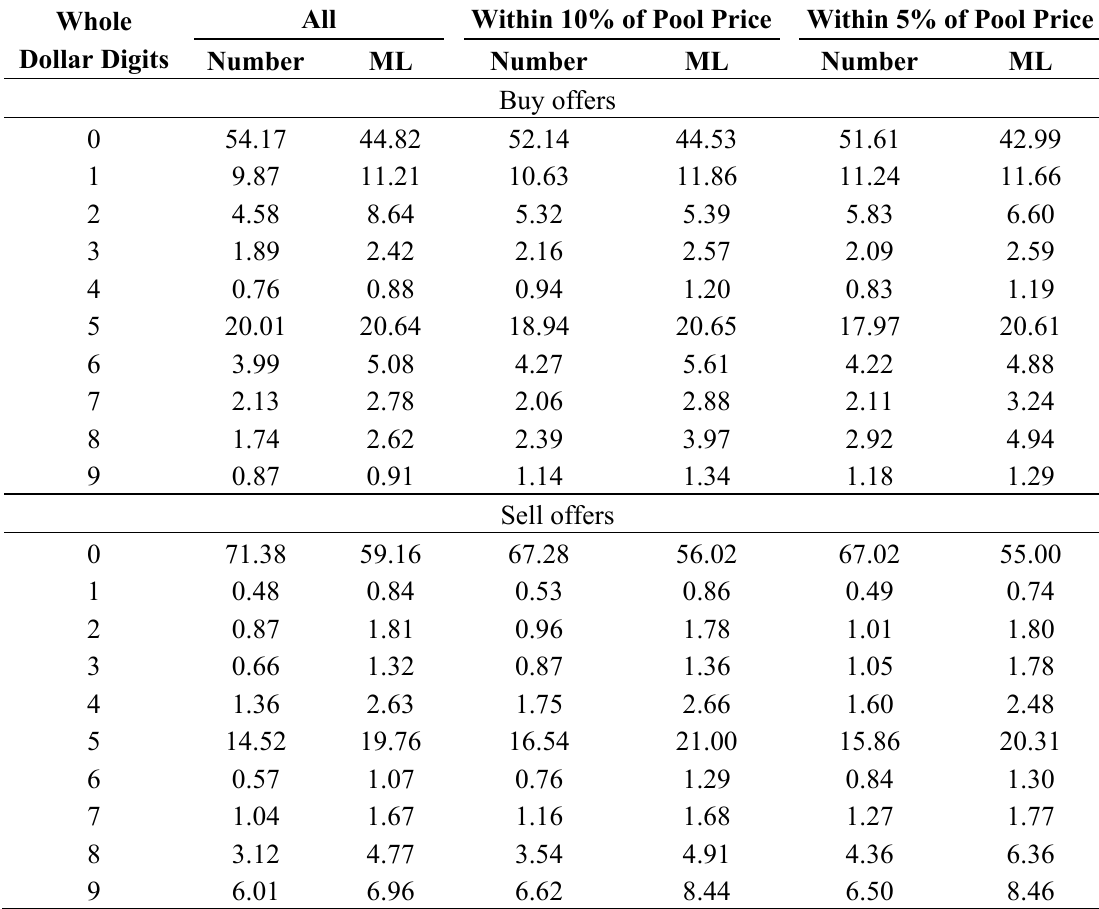
Table 3. Water allocation price clustering at whole dollar digits (%).